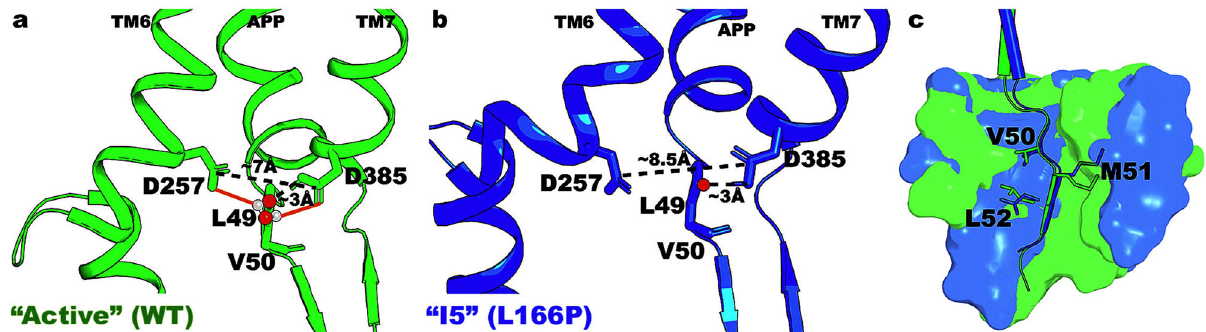
Fig. 4 Comparison between the “ Active ” and “ I5 ” low-energy conformational states in γ -secretase. a The “ Active ” low-energy conformational state of WT PS1, where the distance between residues D257 and D385 is ~7.0 Å. A water molecule formed hydrogen bonds with the two catalytic aspartates and poised for the ε cleavage of the amide bond between residues L49 – V50 of APP. b The “ I5 ” low-energy conformational state of L166P FAD mutant PS1, where the distance between the two catalytic aspartates D257 and D385 is too large at ~8.5 Å to trap a water molecule for the ε cleavage of APP. c Location of APP substrate residues P1 ’ , P2 ’ , and P3 ’ in the “ I5 ” low-energy conformational state compared to “ Active ” WT. The “ Active ” and “ I5 ” low- energy conformational states are shown in green and